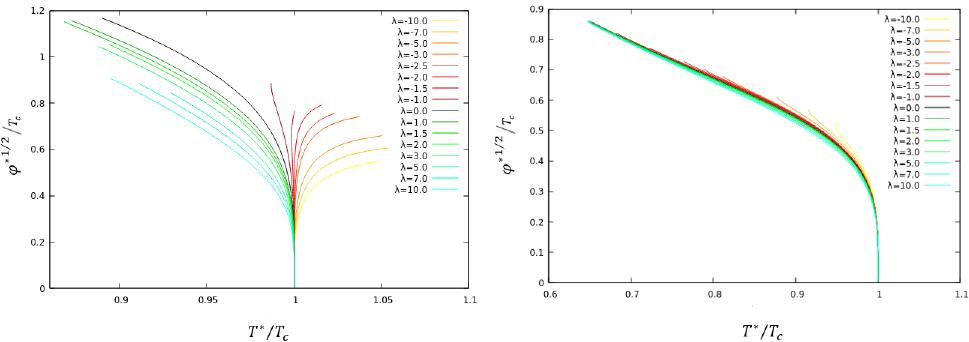
Figure 6. The condensate ϕ 1/2 + / T c for a balanced superconductor as a function of T / T c for several values of λ and (cid:101) = − 0.9 ( left ) and (cid:101) = 0.9 ( right